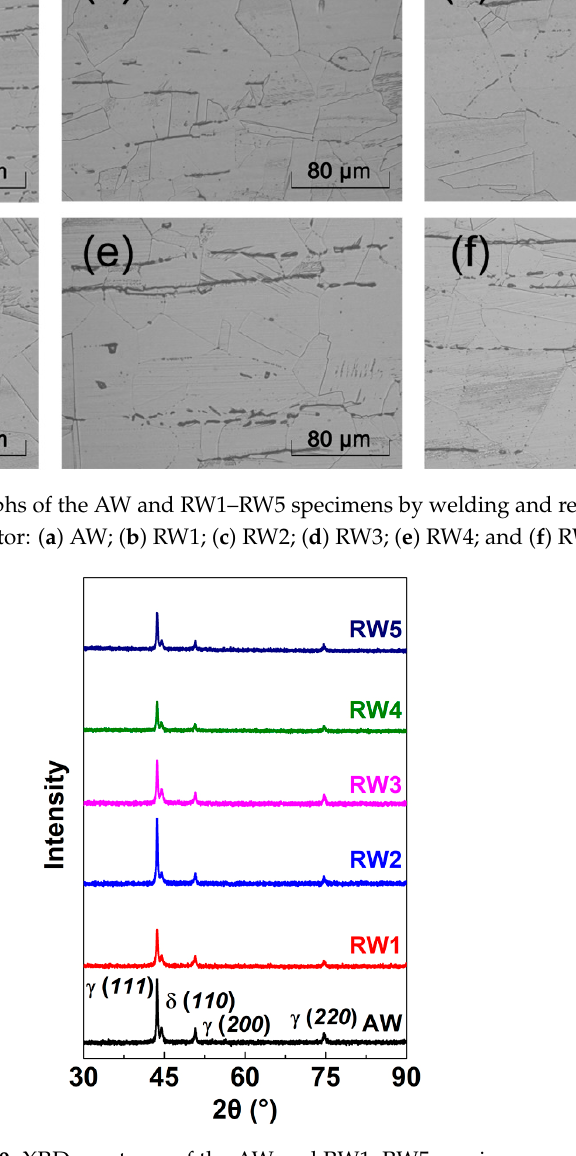
Figure 10. XRD spectrum of the AW and RW1–RW5 specimens.